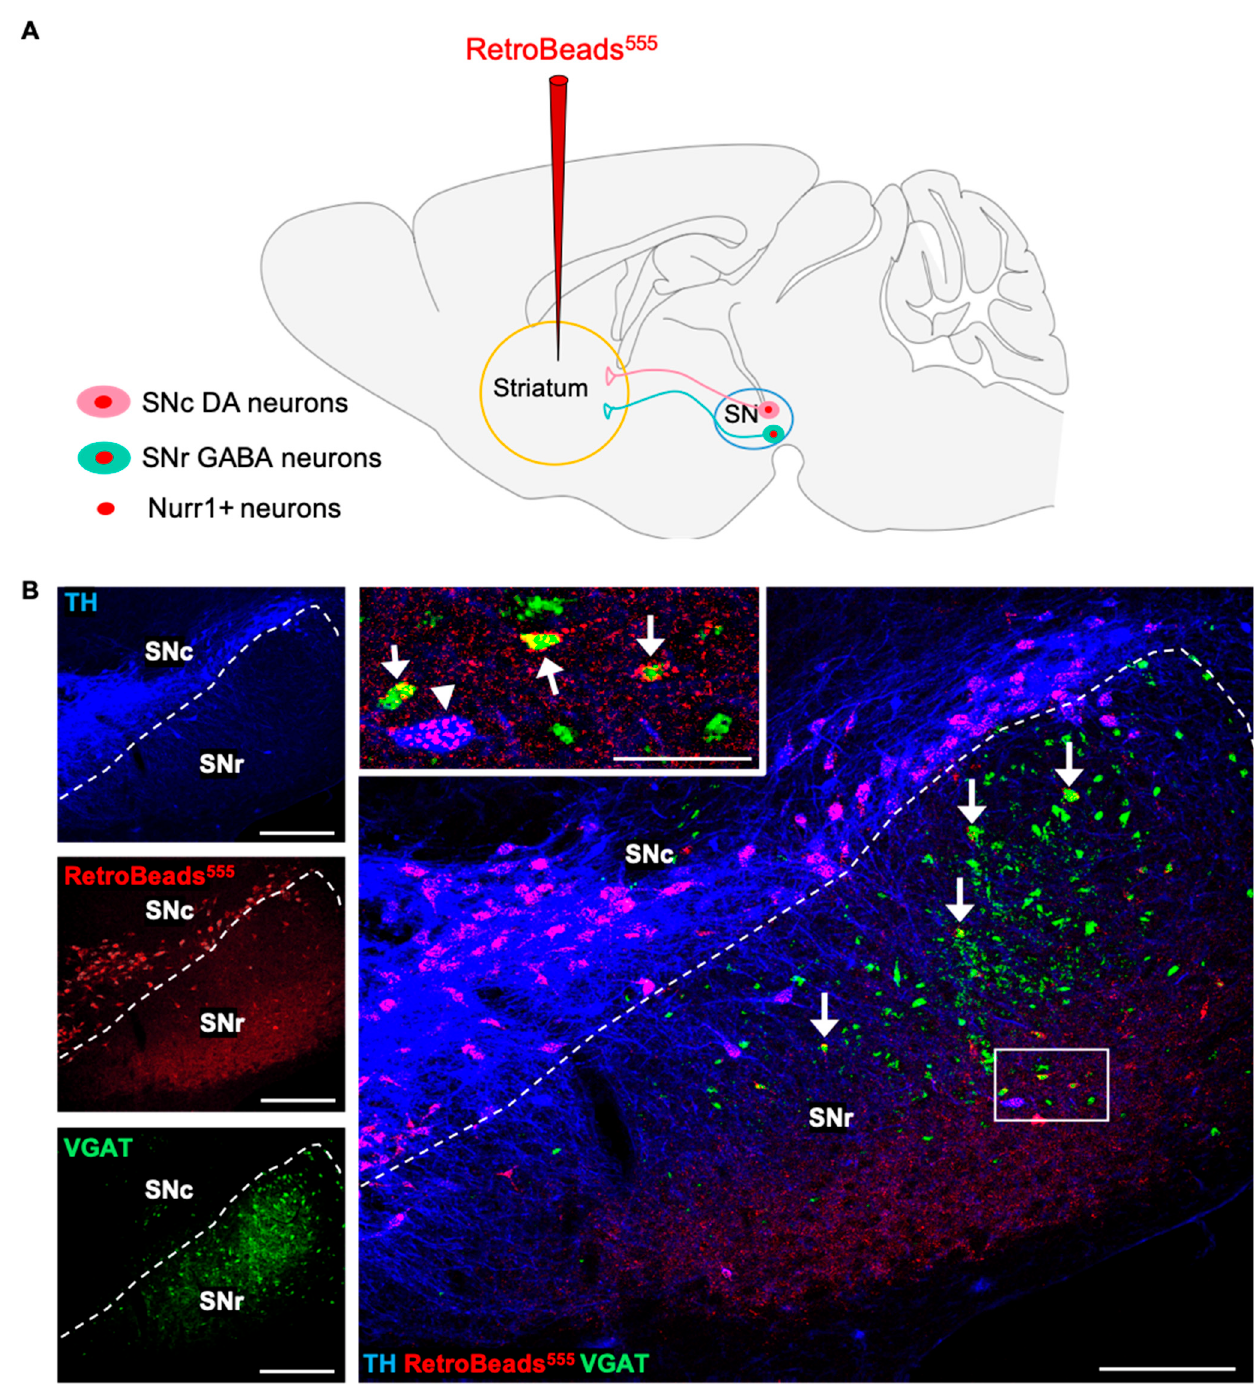
Figure 6. Retrograde tracing revealed the pool of SNr GABAergic neurons projecting to the striatum. ( A ) Schematic diagram illustrating retrograde tracing with RetroBeads (555 nm) injected in the striatum and transported from the neuronal terminals in the striatum back to their somata in the SN. ( B ) Confocal images of representative coronal sections through the SN of adult (P60) VGAT- ZsGreen mice. Inset (white box) shows RetroBeads detected in the somata of both TH+ (arrowhead) and VGAT+ (arrows) neurons in the SNr, revealing the connectivity of GABAergic SNr-to-striatum projection neurons. Scale bars = 200 μ m, 50 μ m (inset).